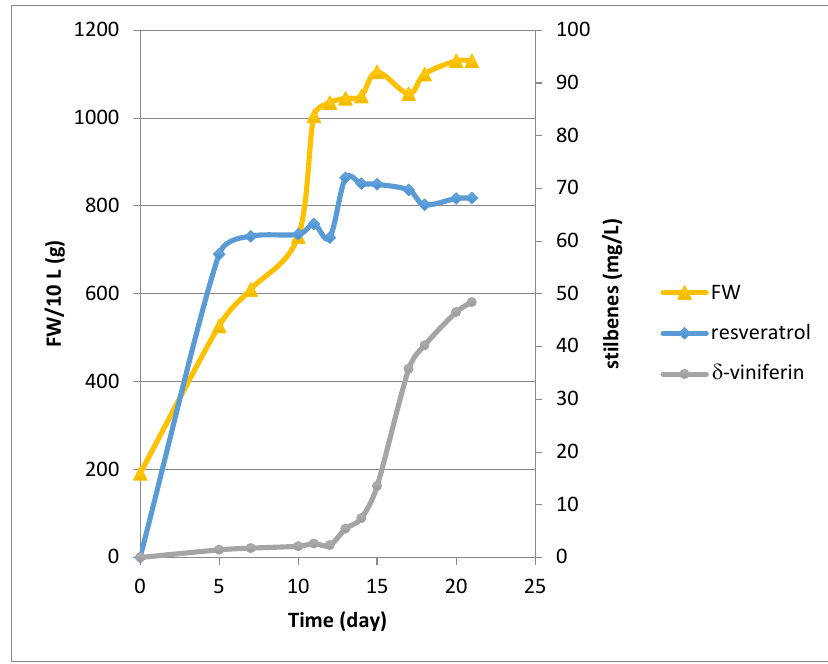
Figure 1. Growth kinetic and stilbene production (resveratrol, δ-viniferin) in the 14 L Bioflo 3000 bioreactor. Concord cells were cultured with CDR from Day 0 to Day 21 and MeJA was added at Day 11.